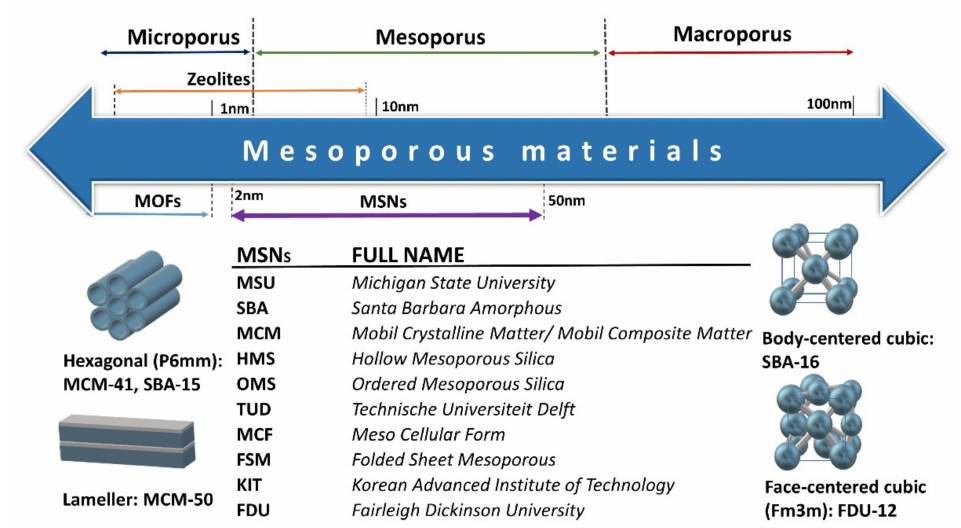
Scheme 2. Schematic representation of various mesoporous materials used as Drug Delivery Sys- tems (DDS).